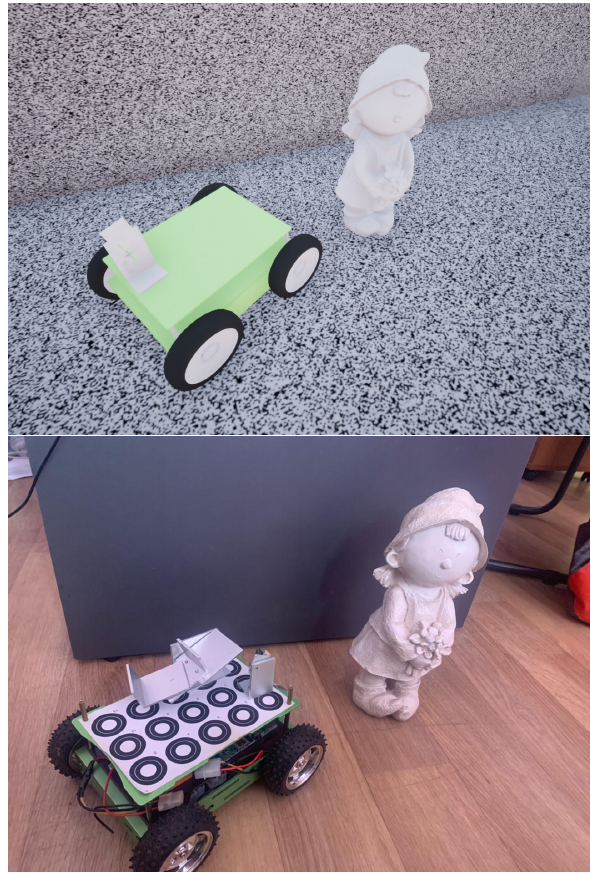
Figure 4. Comparison of virtual (top) and real (bottom) enviroments.